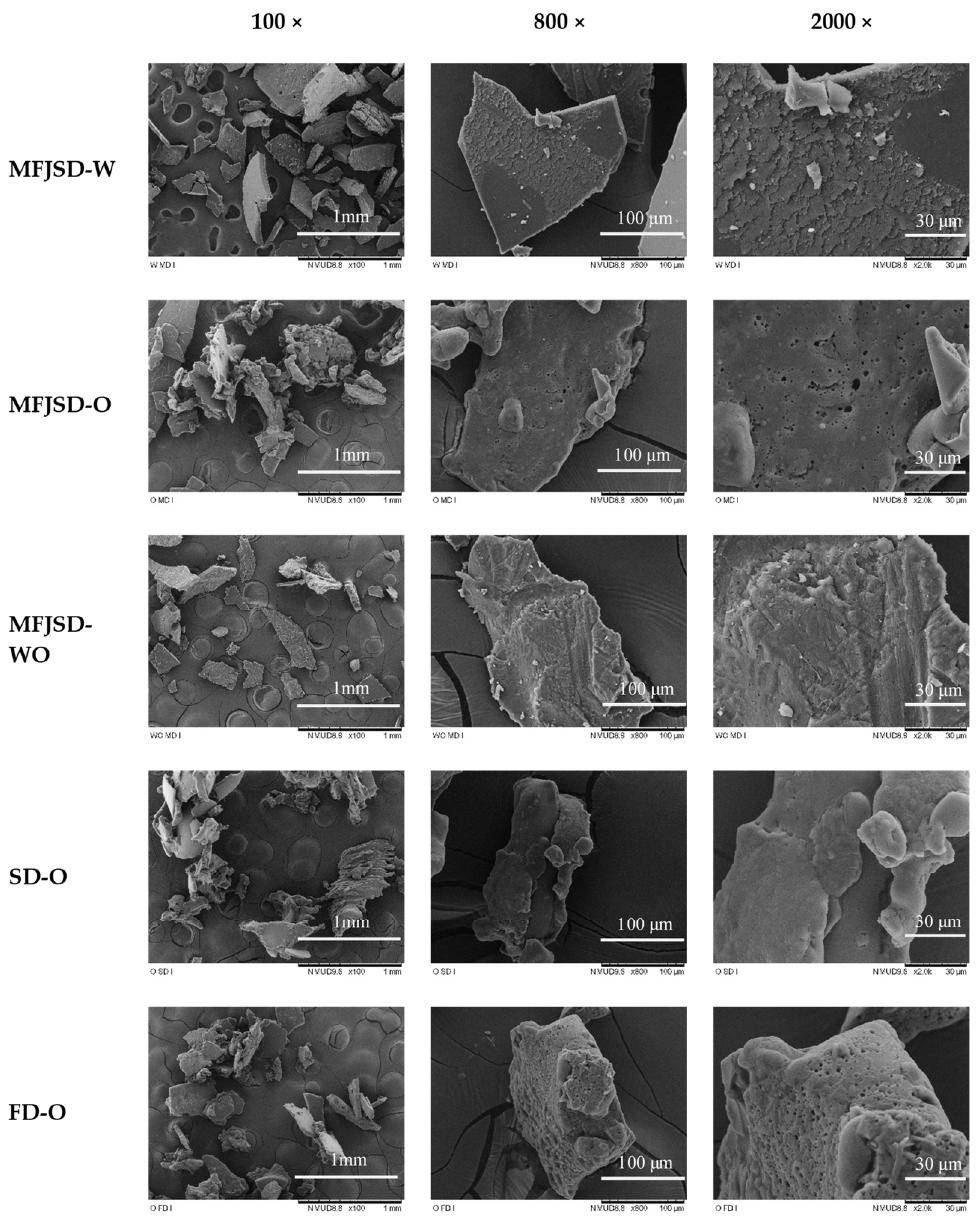
Figure 8. Microstructure of microcapsules after simulated intestinal digestion (magnification: 100×, 800×, 2000×). MFJSD- W, MFJSD-O, and MFJSD-WO: microcapsules produced by microfluidic-jet spray drying, using WPI only, OSA only, and a combination of WPI/OSA (50/50 w/w ) as wall materials, respectively; SD-O: microcapsules produced by two-fluid nozzle spray drying, using OSA only as wall material; FD-O: microcapsules produced by freeze-drying, using OSA only as wall material; WPI: whey protein isolate; OSA: octenylsuccinic anhydride modified starch.